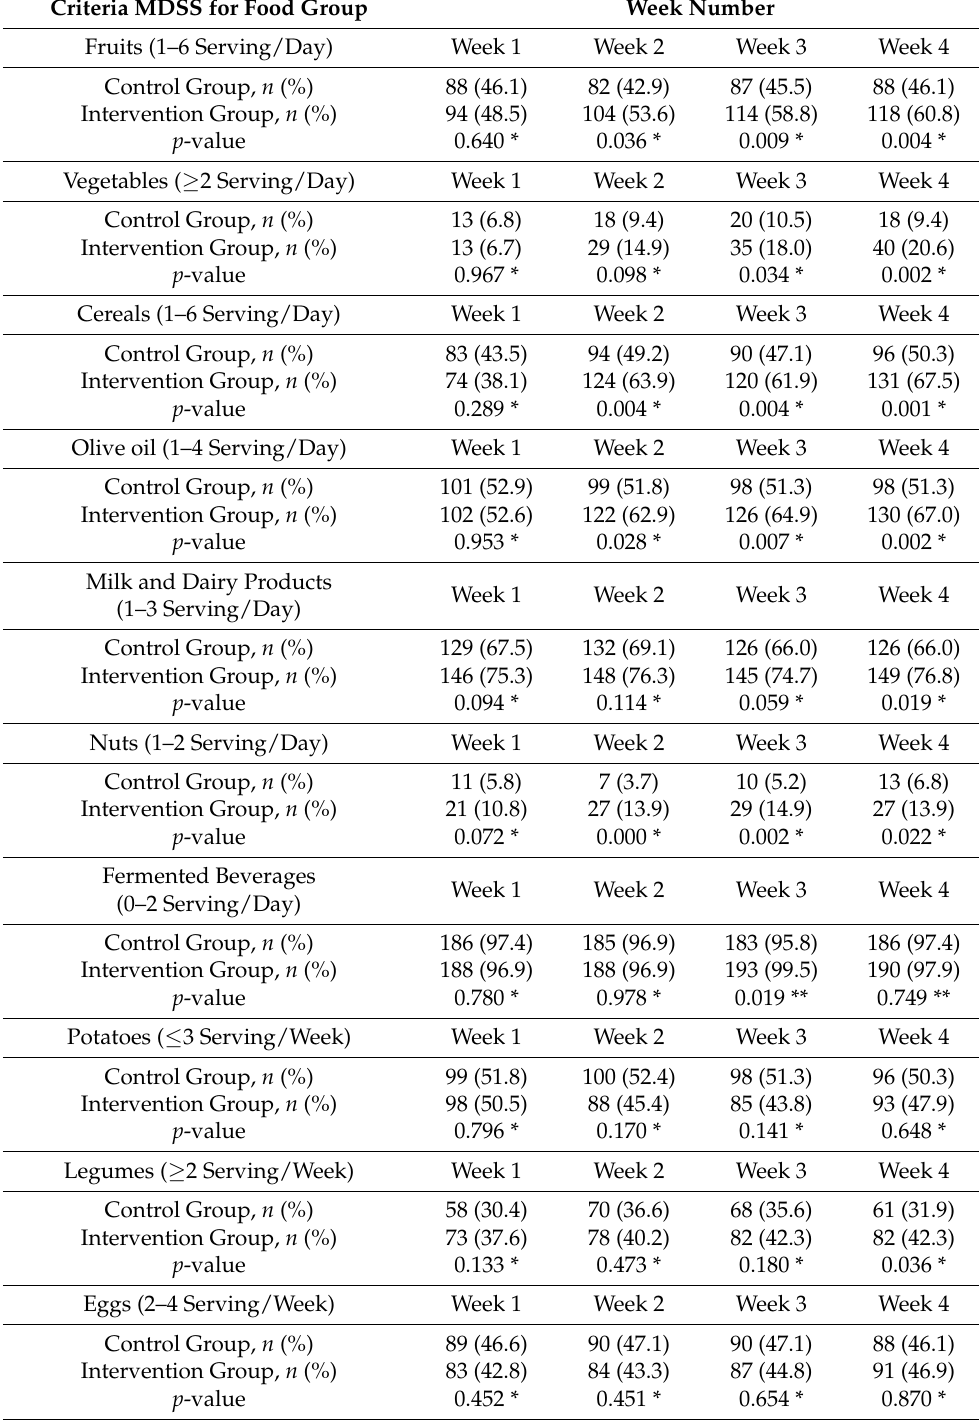
Table 3. Percentage of Participants that Meet the Consumption Criteria of Mediterranean Diet Serving Score (MDSS) Index for Each Food Group Throughout the Four Weeks of Follow-Up in the Whole Study